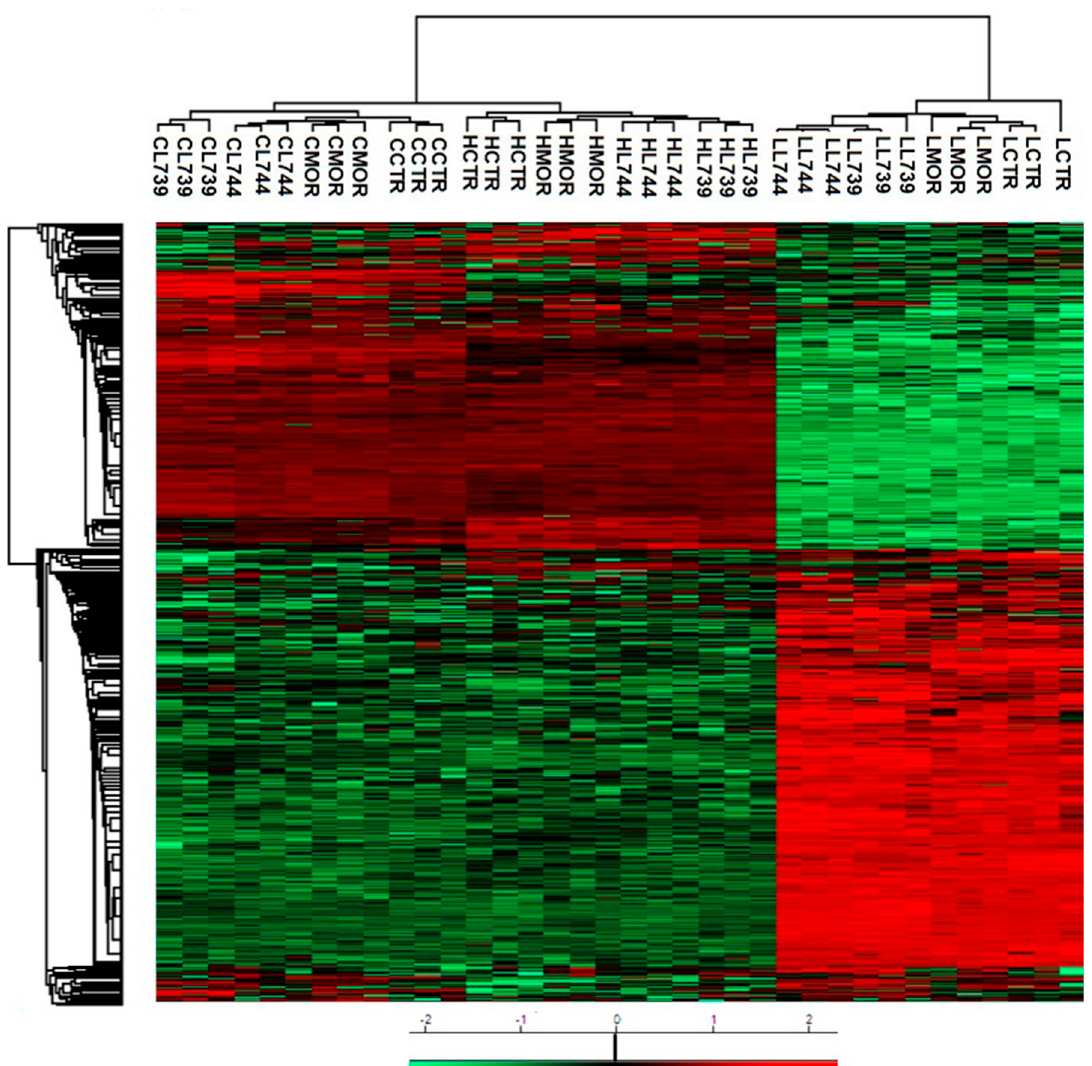
Figure 8. Heatmap showing hierarchical clustering performed on LFQ intensity values (with Per ‐ seus software version 1.6.15.0) of all 6228 proteins identified in rat spleen lymphocytes (L), brain cortex (C), and hippocampus (H) after 7-day treatment with 10 mg/kg of morphine ( MOR ), LYS739 , and LYS744 . Significantly upregulated proteins are labeled in red, significantly downregulated proteins are labeled in green. L739, LYS739 ; L744, LYS744 .